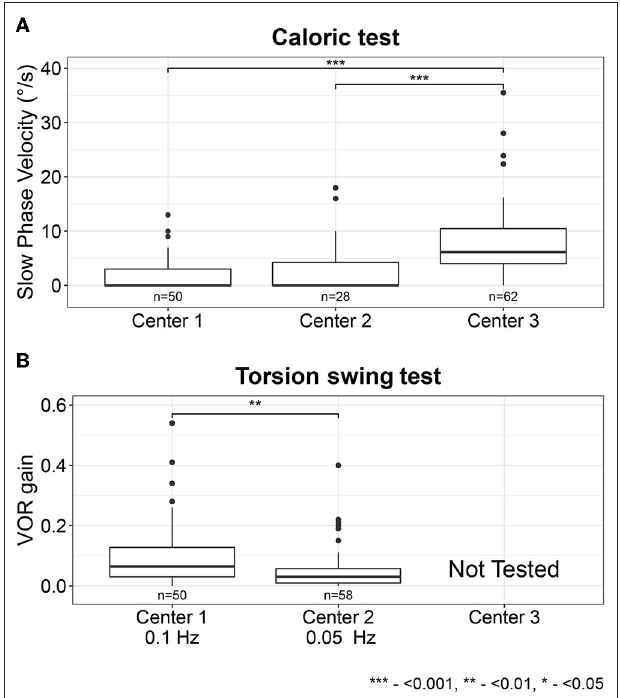
FIGURE 2 | Vestibular test results for the caloric test (sum of the bithermal maximal peak slow phase velocity bilaterally) (A) and torsion swing test (VOR gain) (B) per center. Each box plot represents the 25 to 75 percentiles, bold black lines the median, dots the outliers, and asterisks (*) illustrate statistically significant differences. Statistical significance levels: *** p < 0.001, ** p < 0.01, * p < 0.05.